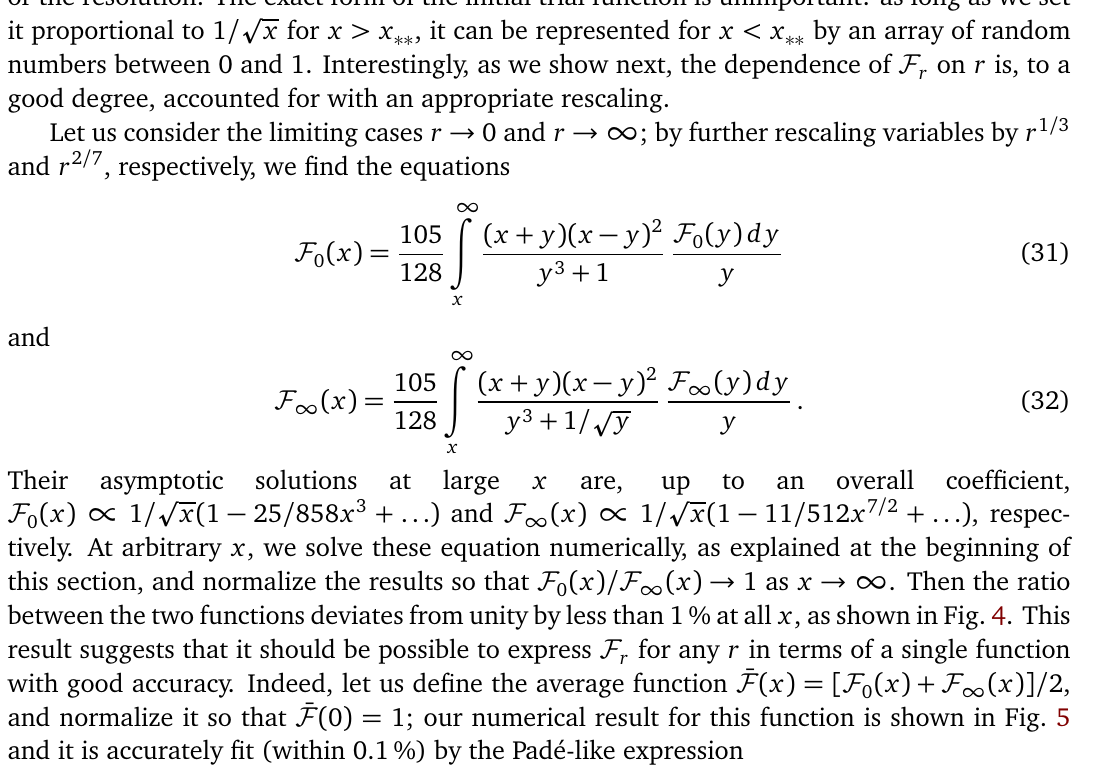
Figure 4: Solid line: deviation of the ratio F numerical solutions to Eqs. (31) and (32). The dashed line is the analytic prediction given by the next-to-leading asymptotic terms [ see text after Eq. (32) ] ; the agreement between the two curves at large x further validates our numerical